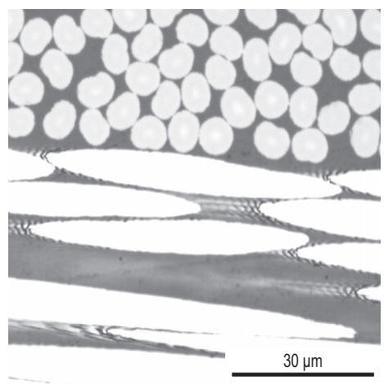
Presence of light interference pattern around the sharp edges of longitudinal fibres in a finely polished laminate section (bright-field illumination, 50× objective; Cycom® 5320T650 Unitape).